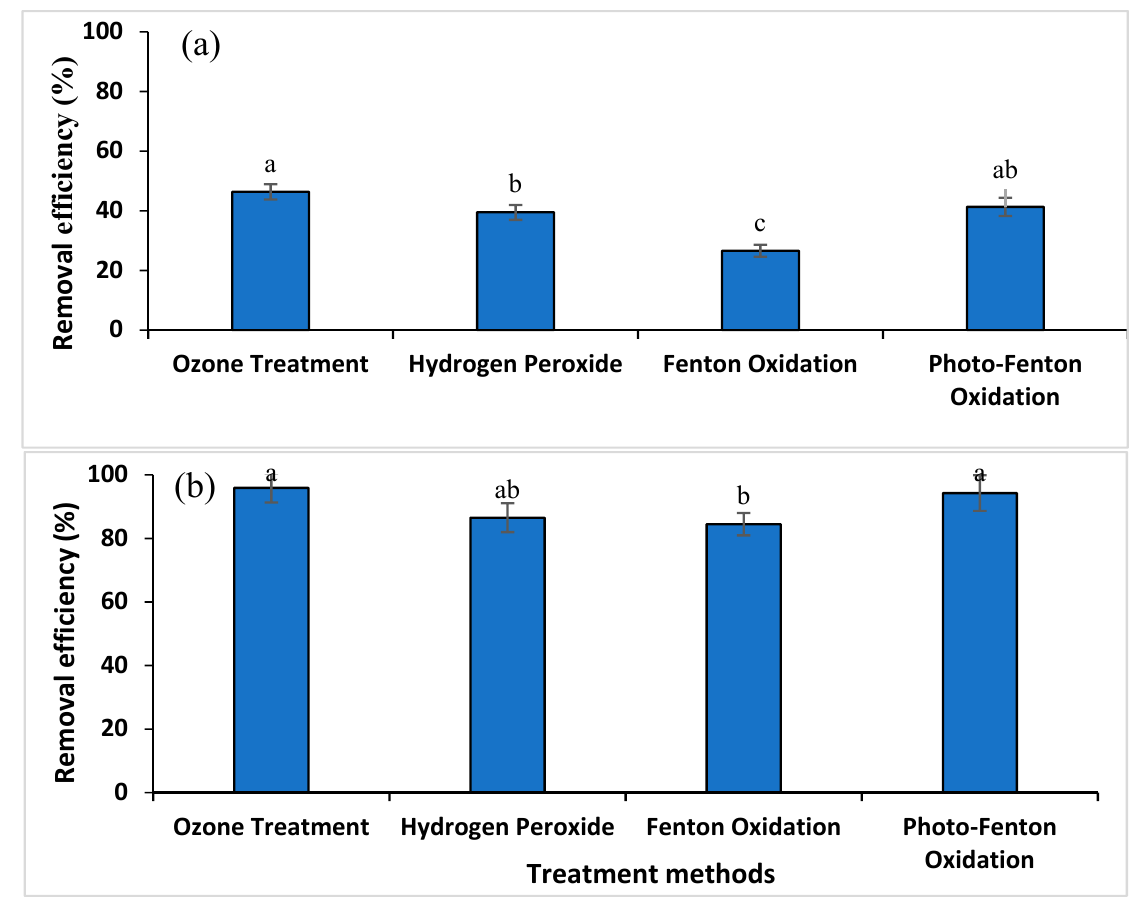
Figure 11. ( a ) Comparison of color removal efficiencies of different treatment methods applied to biologically treated pulp and paper wastewater. ( b ) Comparison of COD removal efficiencies of different treatment methods applied to biologically treated pulp and paper wastewater. Mean values are presented with standard deviation. Different letters (a–c) show significant differences between treatment methods. Same letters (a, a, a) show that there is no significant difference between treatment methods. Table 2. Various effective wastewater treatment methods for the paper and pulp industries. S.